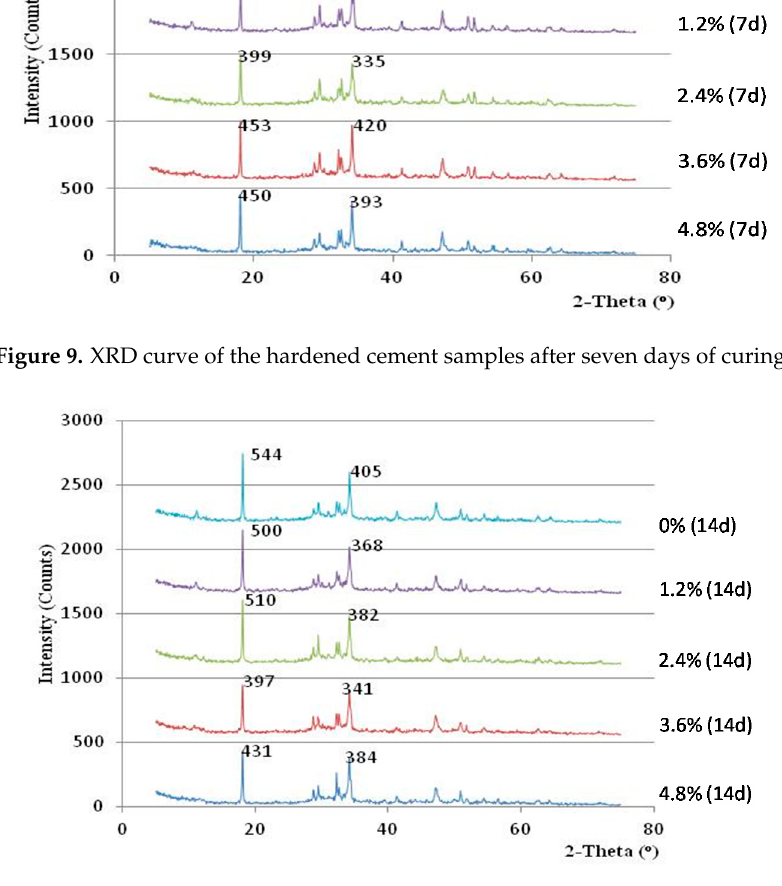
Figure 10. XRD curve of the hardened cement samples after 14 days of curing.